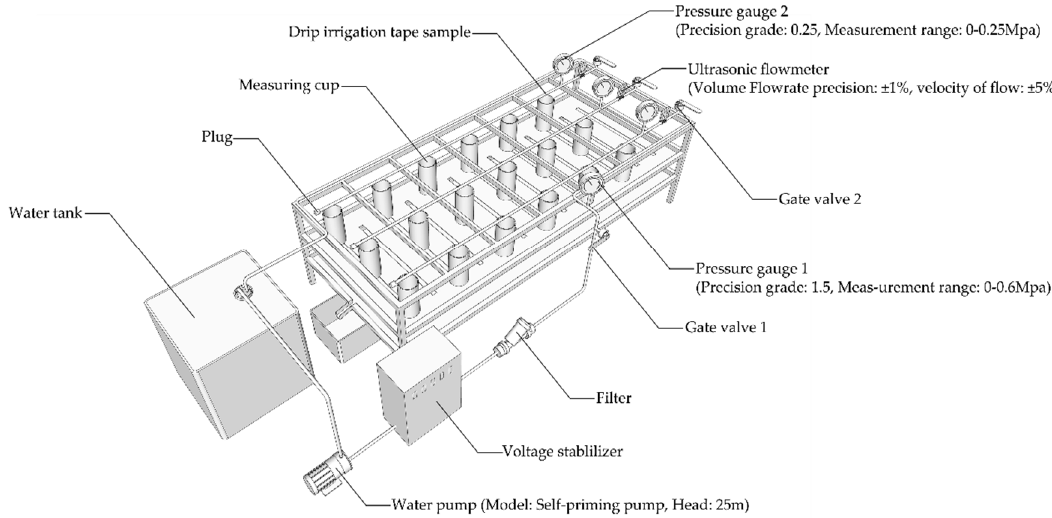
Figure 2. Schematic diagram of the hydraulic performance test setup and its connections.